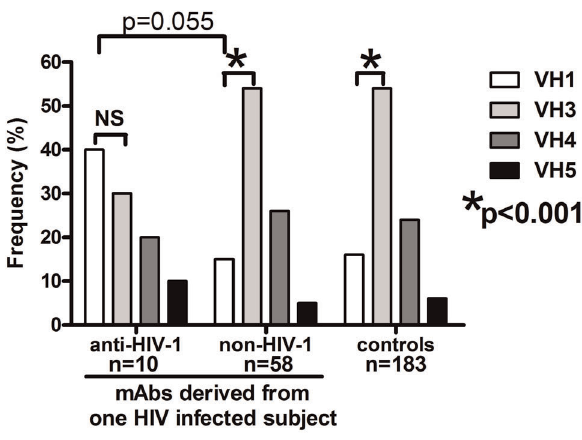
Figure 2. The usage of VH family genes by human anti-HIV-1 and non-HIV-1 mAbs. These mAbs were produced from single B cells derived from one HIV infected individual and are compared to antibodies with undefined specificities produced from single B cells of four healthy control subjects [21]. The preferential usage of the VH3 versus VH1 family genes by non-HIV-1 mAbs compared controls and significantly increased usage of VH1 family genes of anti-HIV-1 versus non-HIV-1 mAbs was determined by the Chi-Squared test. NS – not significant.